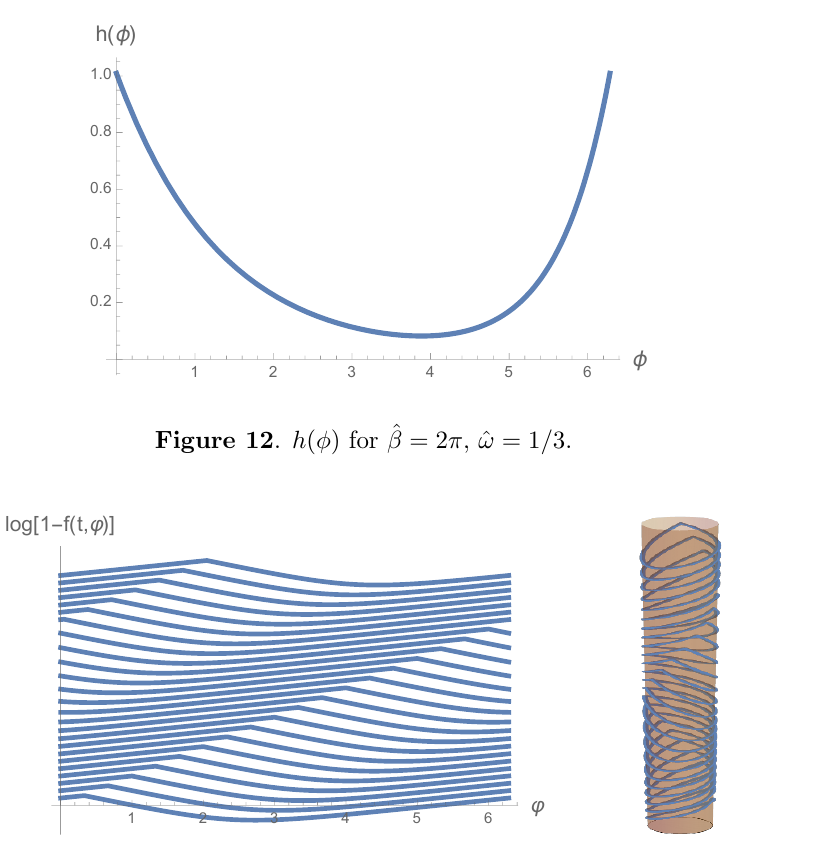
Figure 13 . Snapshots of log [1 (cid:0) f ( t; ’ )] for ^ (cid:12) = 2 (cid:25); ^ ! = 1 = 3 at di(cid:11)erent times as a function of ’ . On the right we plot the same snapshots on the cylinder so that the periodicity of ’ is manifest.